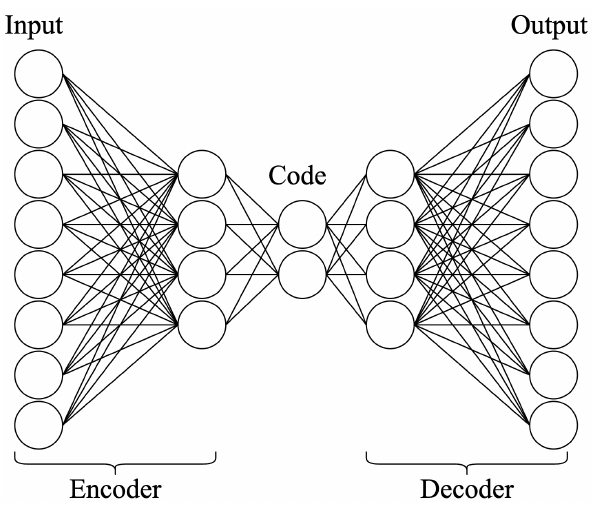
Figure 23. A diagram of an autoencoder. On the left, an example structure of an encoder is depicted. The input layer has more units than the middle layer, where the input is compressed into a lower- dimensional representation (the code). On the right, the decoder decompresses the code back to the original